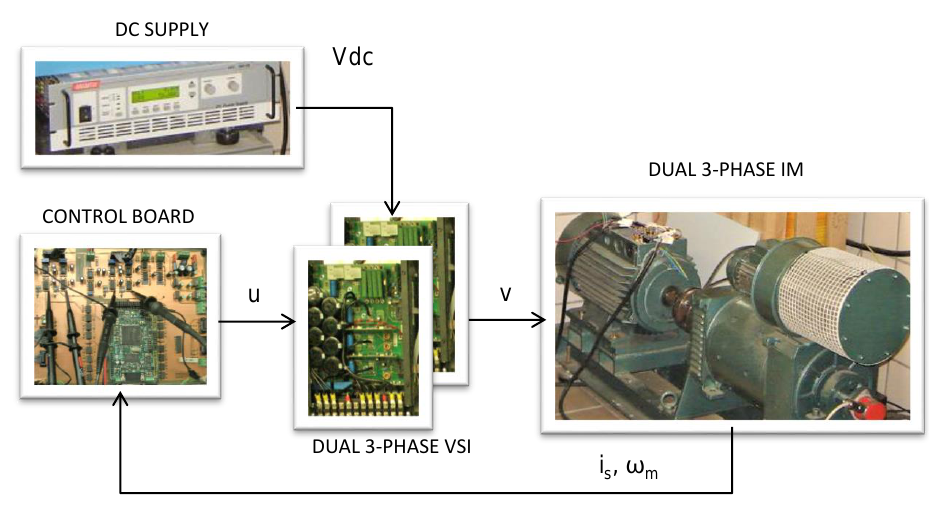
Figure 3. Diagram of the experimental setup including photographs of various